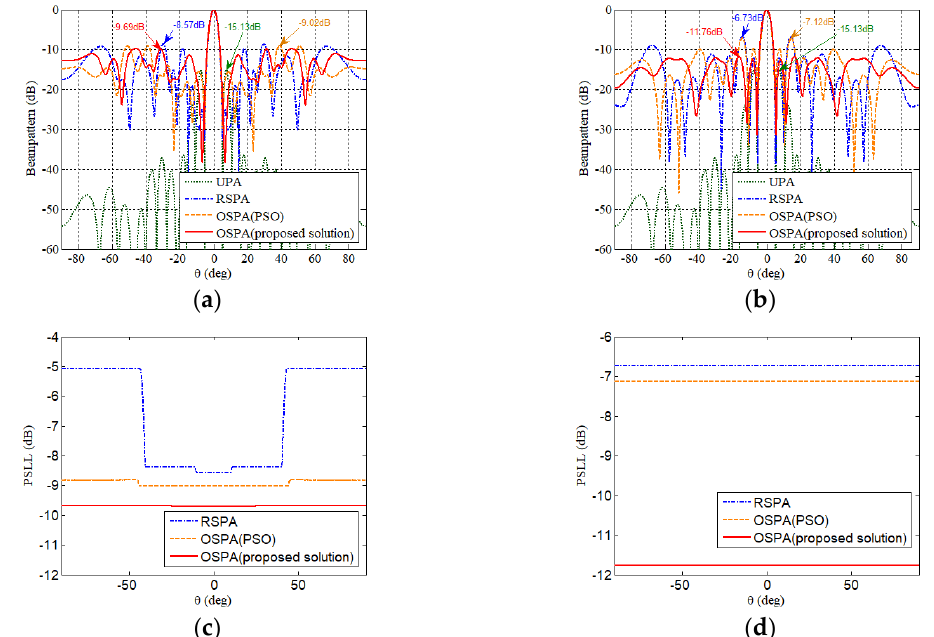
Figure 2. The beampatterns of the RSPA, the UPA and the OSPA by the proposed solution and PSO in ( a ) the 𝜑 = 60° plane (the main-lobe is at (0°,60°) ) and ( b ) the 𝜑 = 120° plane (the main-lobe is at (0°,120°) ). The PSLLs of beampatterns versus different beam shifting directions 𝜃 in the ( c ) 𝜑 = 60° , and ( d ) 𝜑 = 120° planes.